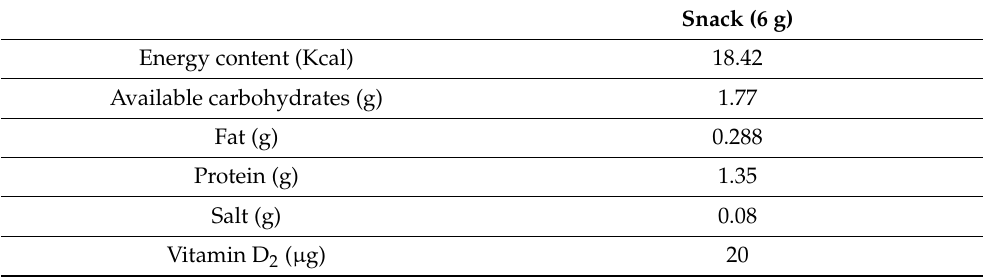
Table 1. Nutritional composition of the